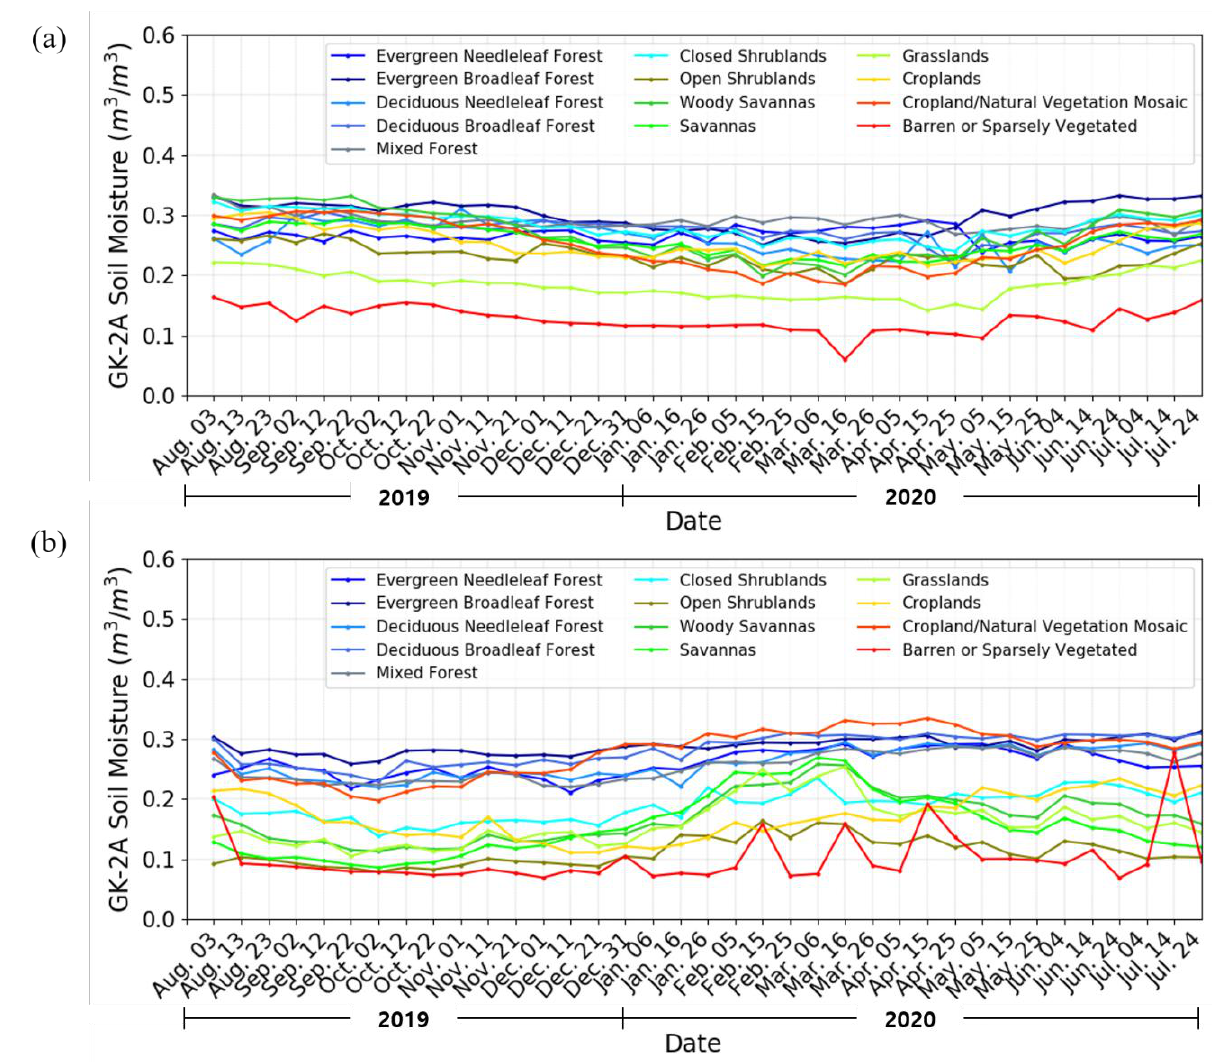
Figure 11. Temporal variations in the 10-day-averaged GK-2A SM for each land cover type in ( a ) East Asia and ( b ) Australia from August 2019 to July 2020.